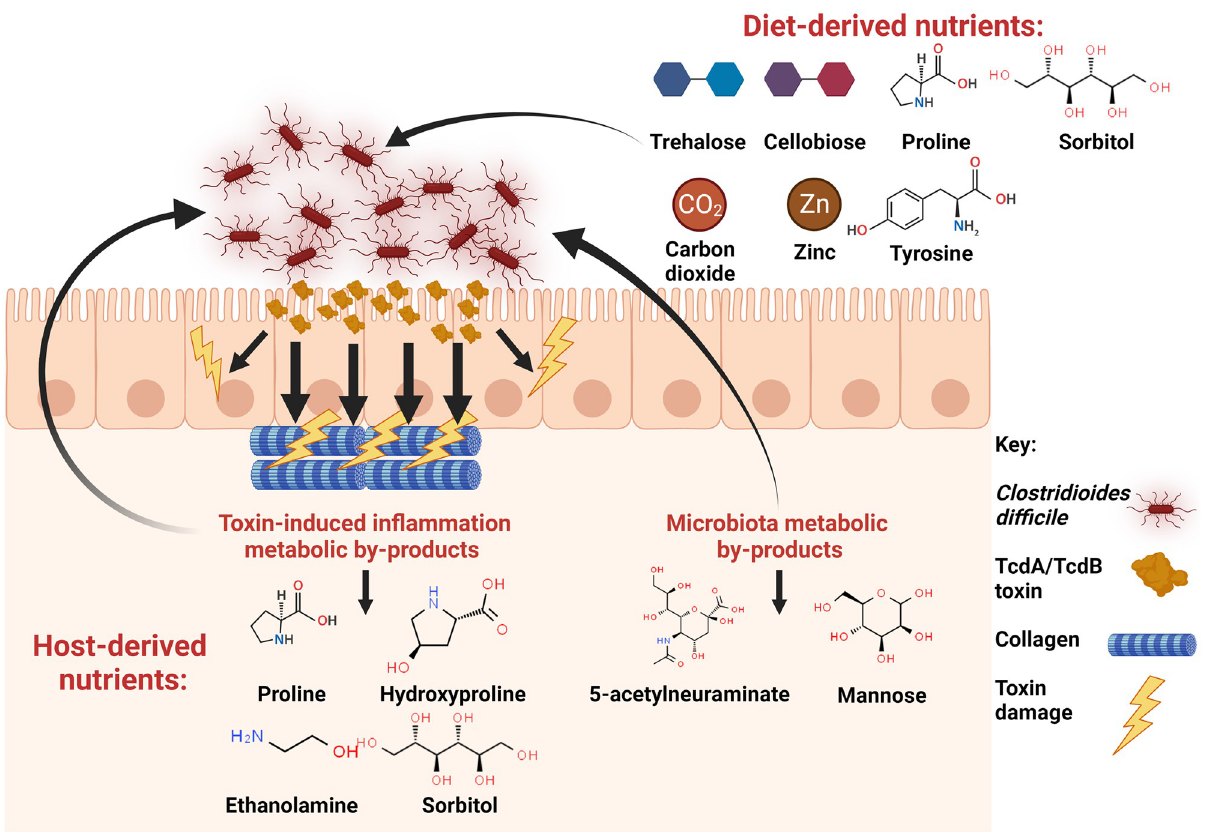
Fig 2. Overview of the nutrients C . difficile utilises and their origin during infection of the gut. Molecular structures acquired from Chemspider. com. Created with Biorender.com.